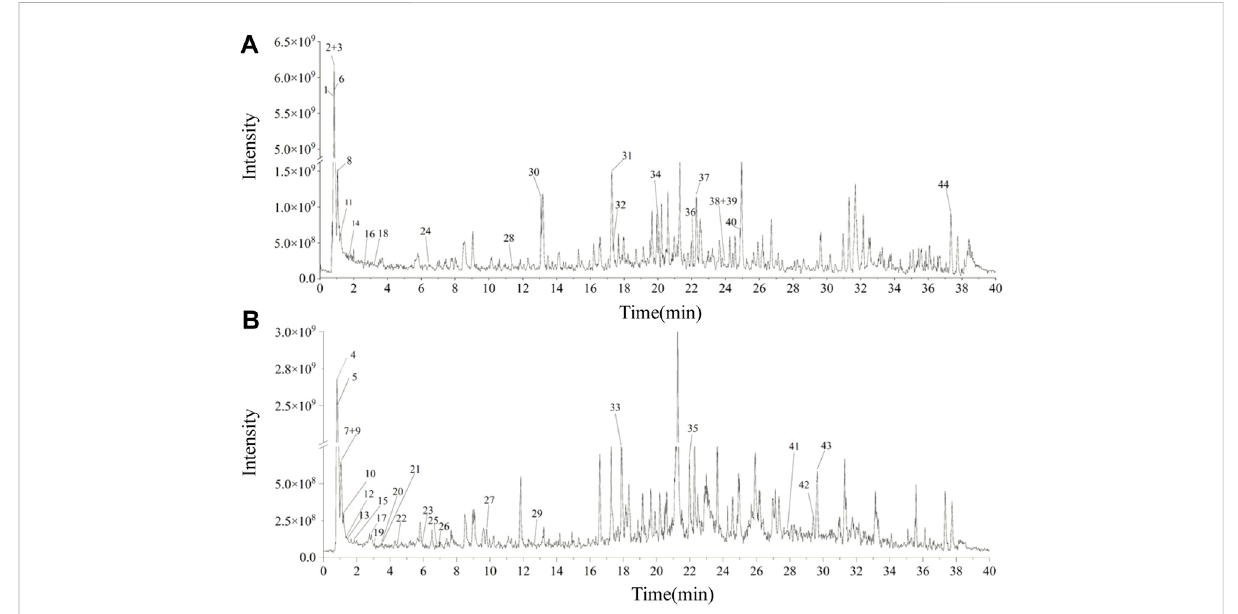
FIGURE 1 The total ion chromatograms of UEE. (A) Total ion chromatograms of UEE in the (+)-ESI. (B) Total ion chromatograms of PMC in the ( −